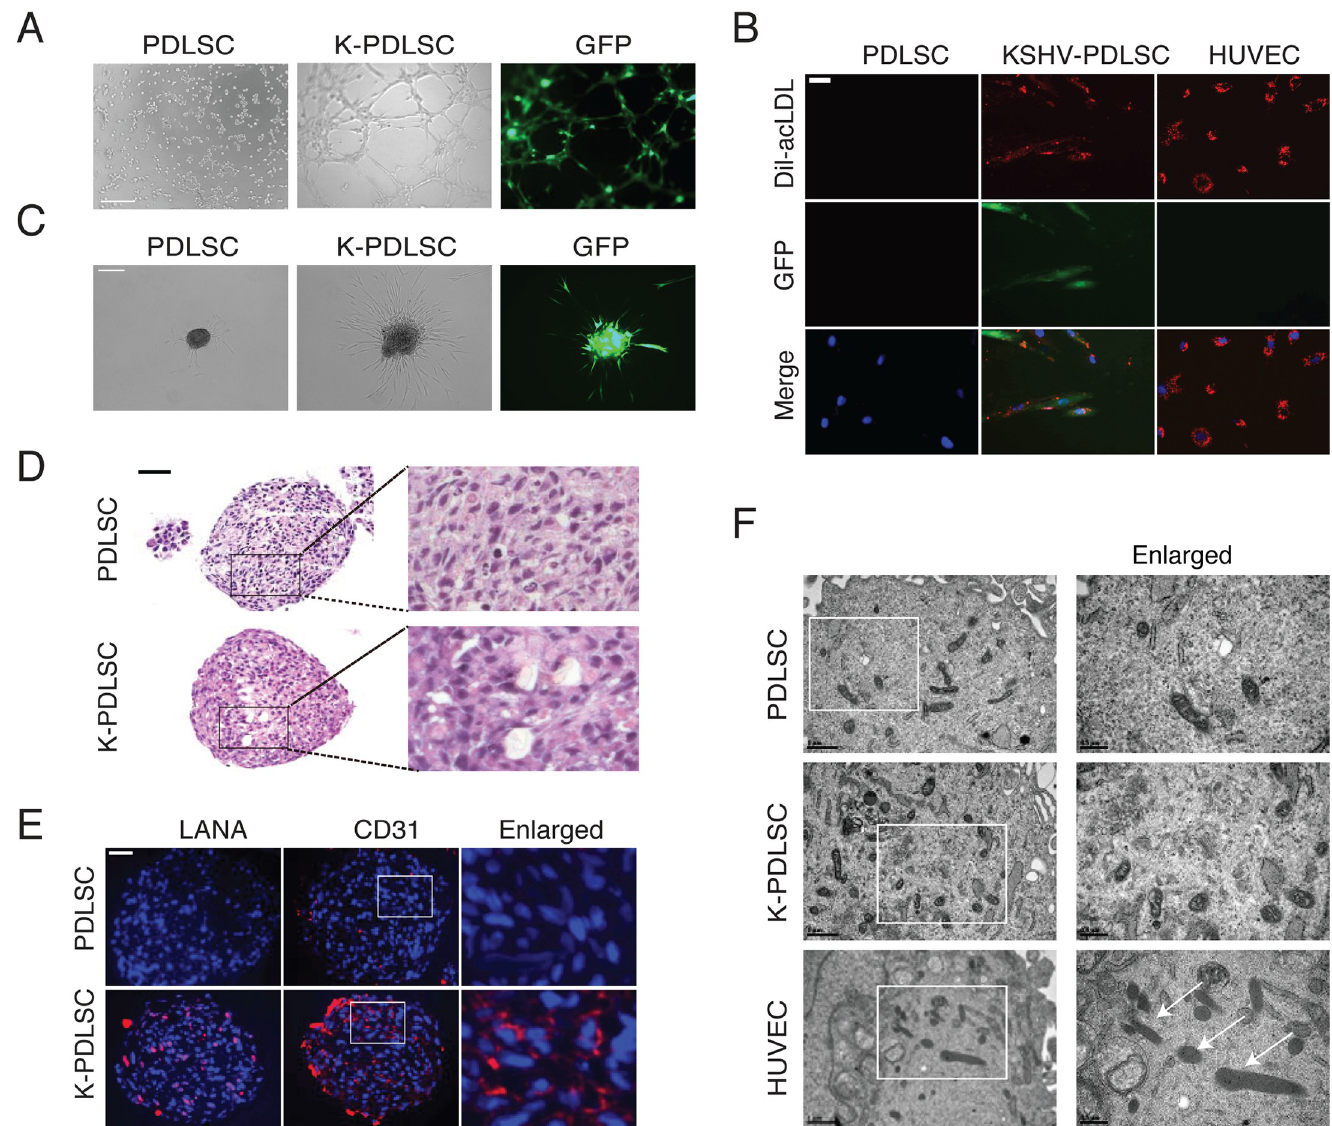
hours. DiI-acLDL uptake (red), as well as KSHV-GFP infection (green), were analyzed with a fluorescence microscope. Scale bar, 100 μ m. ( C) Mock- and KSHV- infected PDLSC spheroids were embedded into Matrigel, and the sprouting length was analyzed by a Zeiss fluorescence microscope. Scale bar, 200 μ m. ( D) H&E staining of PDLSC and K-PDLSC spheroid sections. Scale bar, 50 μ m. ( E) The expression of CD31 in the spheroids of PDLSC and K-PDLSC was detected by IFA. Scale bar, 50 μ m. ( F) Mock- and KSHV-infected PDLSCs, along with HUVECs, were examined for Weibel–Palade bodies (WPBs) under a transmission electron microscope. Scale bar, 1 μ m. Original magnification, × 2 (enlarged